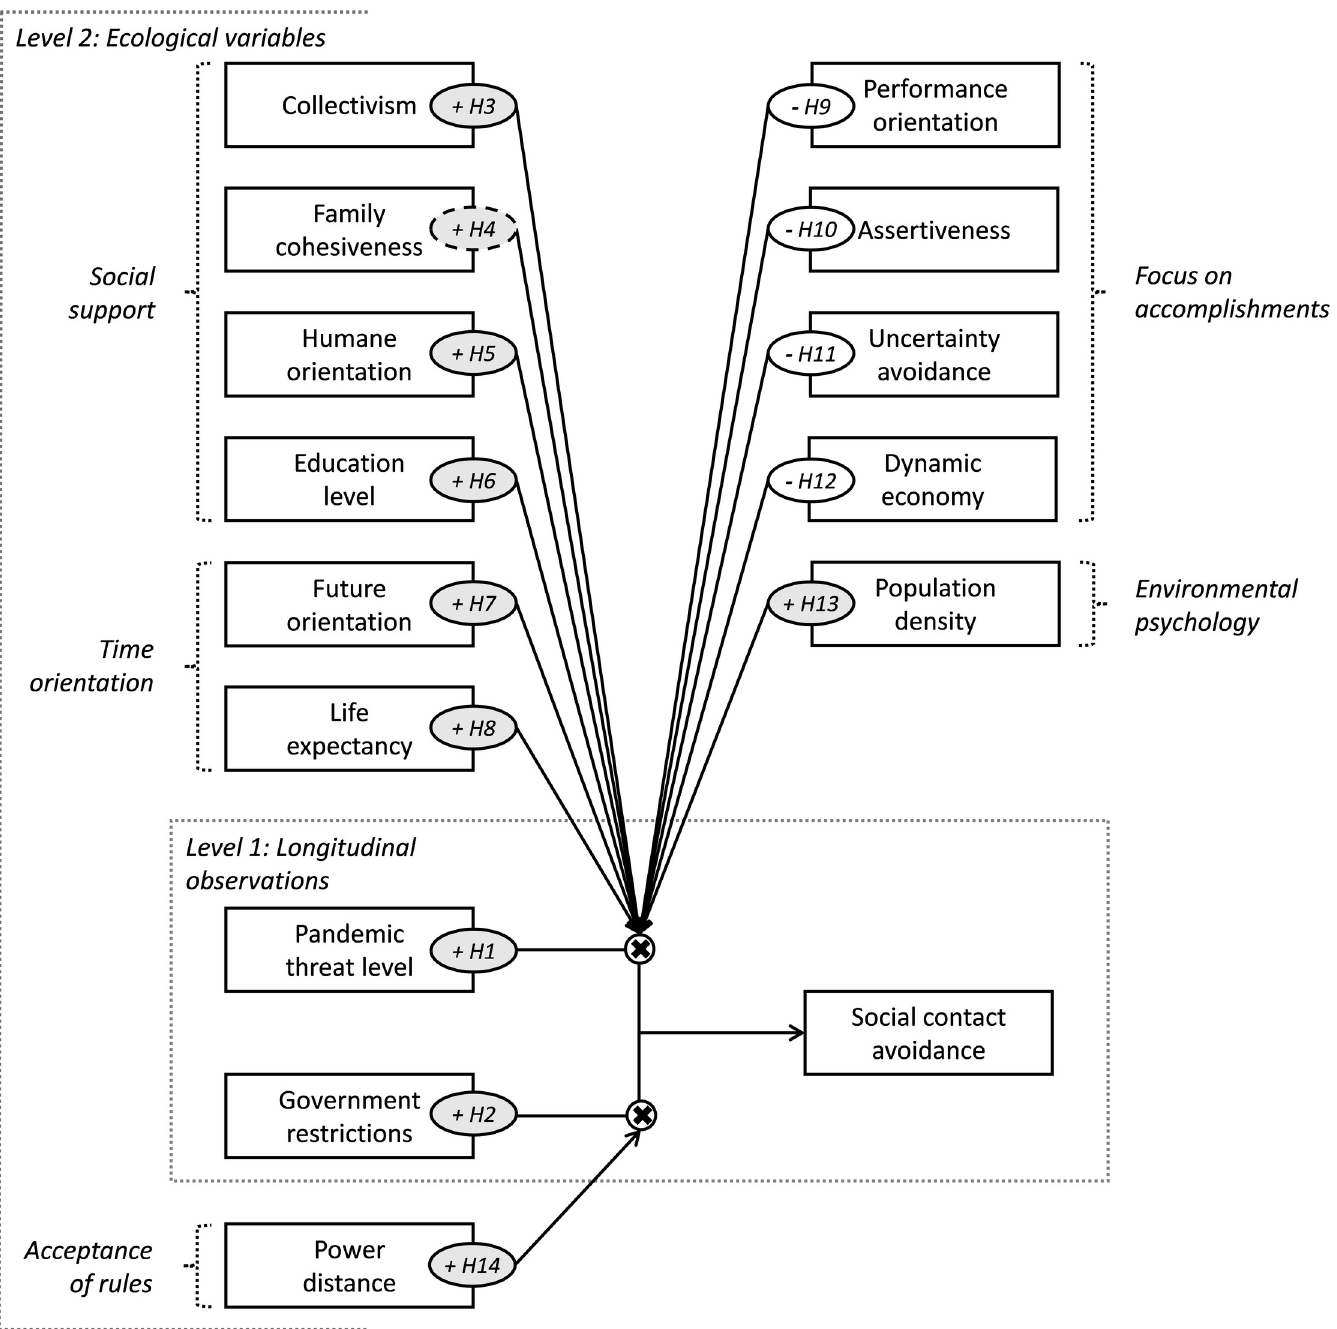
Fig 1. Research model. This diagram depicts the research model as a multilevel model with longitudinal country-level observations at level 1 and ecological country variables at level 2. Nested frames (grey dotted lines) indicate levels of sampling, boxes indicate variables, and arrows represent effects. Hypotheses are referenced in ellipses; the plus or minus sign in the grey or white ellipse indicate a positive or negative effect, respectively. A dashed ellipse (for H4) means that the effect is directionally indicative, but not statistically significant. Variables modelling the level-1 variance are not shown in the diagram, but are included in the statistical model.